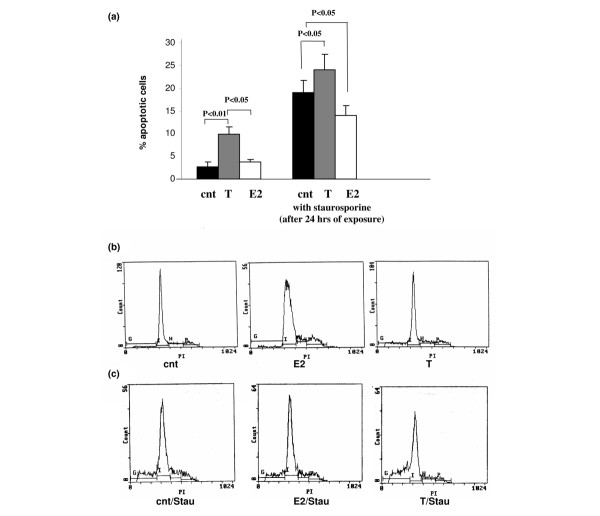
Apoptosis evaluation in cultured human THP-1 cell line. (a) Apoptosis evaluation in the cultured human THP-1 cell line after 168 hours of hormonal treatment without and with staurosporine. Results are expressed as the mean ± standard deviation of the percentage number of annexin-positive cells in five different experiments. (b) Apoptotic DNA evaluation in THP-1 cells after 168 hours of hormonal treatment without staurosporine as detected by flow analysis cytometry scatter analysis. Region G, control (cnt), 3.96%; 17β-oestradiol (E2), 5.54%; testosterone (T), 15.9%. (c) Apoptotic DNA evaluation in THP-1 cells after 168 hours of hormonal treatment and staurosporine (stau) for 24 hours, as detected by flow analysis cytometry scatter analysis. Region G: control/S, 18.9%; E2/S, 16.5%; T/S, 24.5%. PI, propidium iodide.